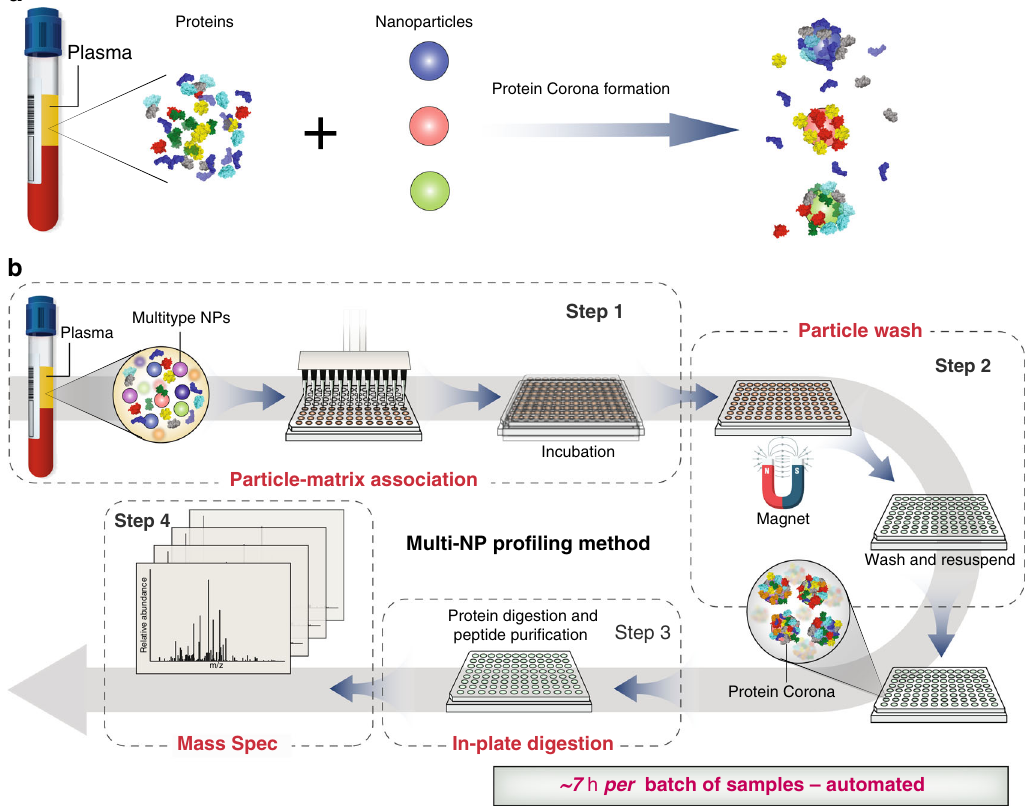
Fig. 1 Schematic of work fl ow of the Proteograph. a Formation of NP protein corona. Different NP physicochemical properties (indicated by three different colors) led to the formation of different protein corona compositions on the NP surface. b Proteograph platform work fl ow based on multi-NP protein corona approach and mass spectrometry for plasma proteome analysis. The Proteograph work fl ow includes four steps: (1) NP-plasma incubation and protein corona formation; (2) NP protein corona puri fi cation by a magnet; (3) digestion of corona proteins; and (4) LC-MS/MS analysis. In this context, each plasma-NP well is a sample, for a total of 96 samples per